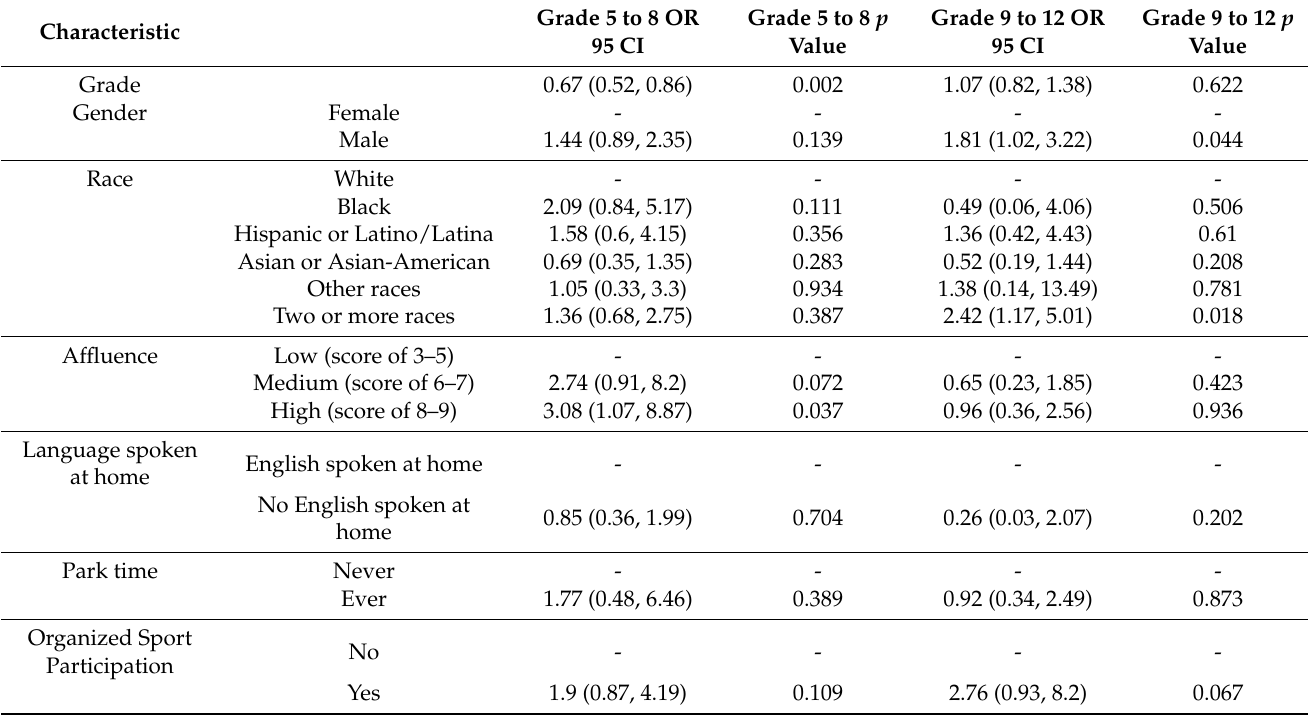
Table 4. Characteristics Associated with Meeting the Physical Activity